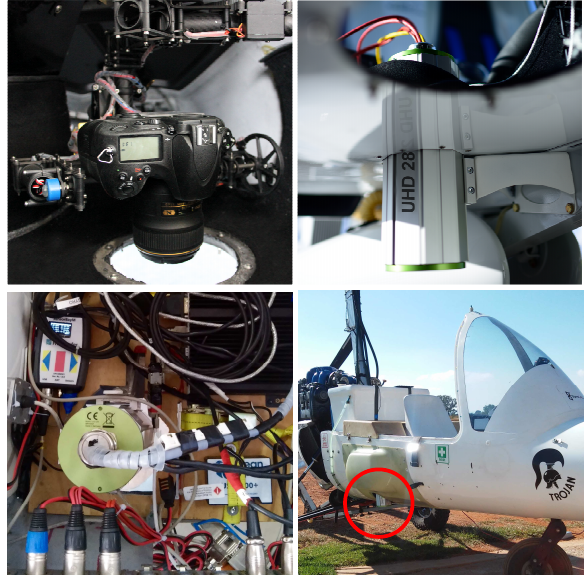
Figure 4. Top left: On-board RGB-VIS camera mounted in a stabilization platform for permanently nadir viewing angle. Top right: Hyperspectral imager UHD 285 integrated in an aircraft (here: CloudDancer2). Bottom left: Inside view of hyperspectral imager UHD 285 integrated in an aircraft (here: Trojan, Wagtail Aviation) owned by a partner situated in South Africa. Bottom right: Outside view of the same configuration in the Trojan